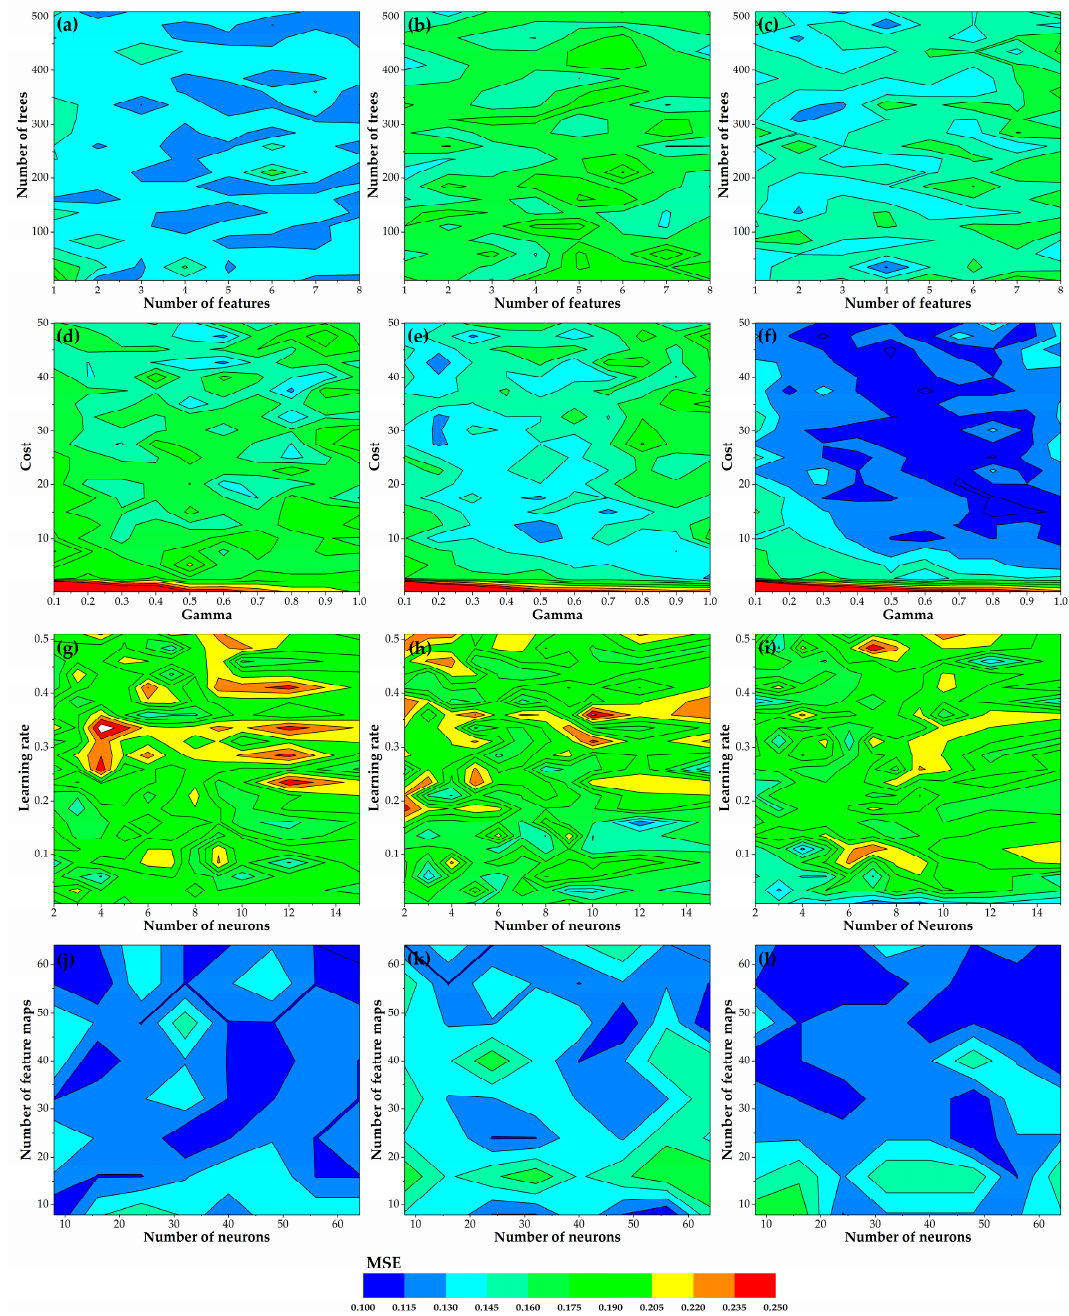
Figure 8. Results of sensitivity analyses showing the classification errors (MSE) for possible combinations of parameters for training each machine learning model: Number of trees and number of features used for training RF models based on Dataset 1 ( a ), Dataset 2 ( b ), and Dataset 3 ( c ); gamma and cost used for training SVM models based on Dataset 1 ( d ), Dataset 2 ( e ), and Dataset 3 ( f ); number of neurons and learning rate used for training ANN models based on Dataset 1 ( g ), Dataset 2 ( h ), and Dataset 3 ( i ); number of feature maps and number of neurons used for training CNN models based on Dataset 1 ( j ), Dataset 2 ( k ), and Dataset 3 ( l ).